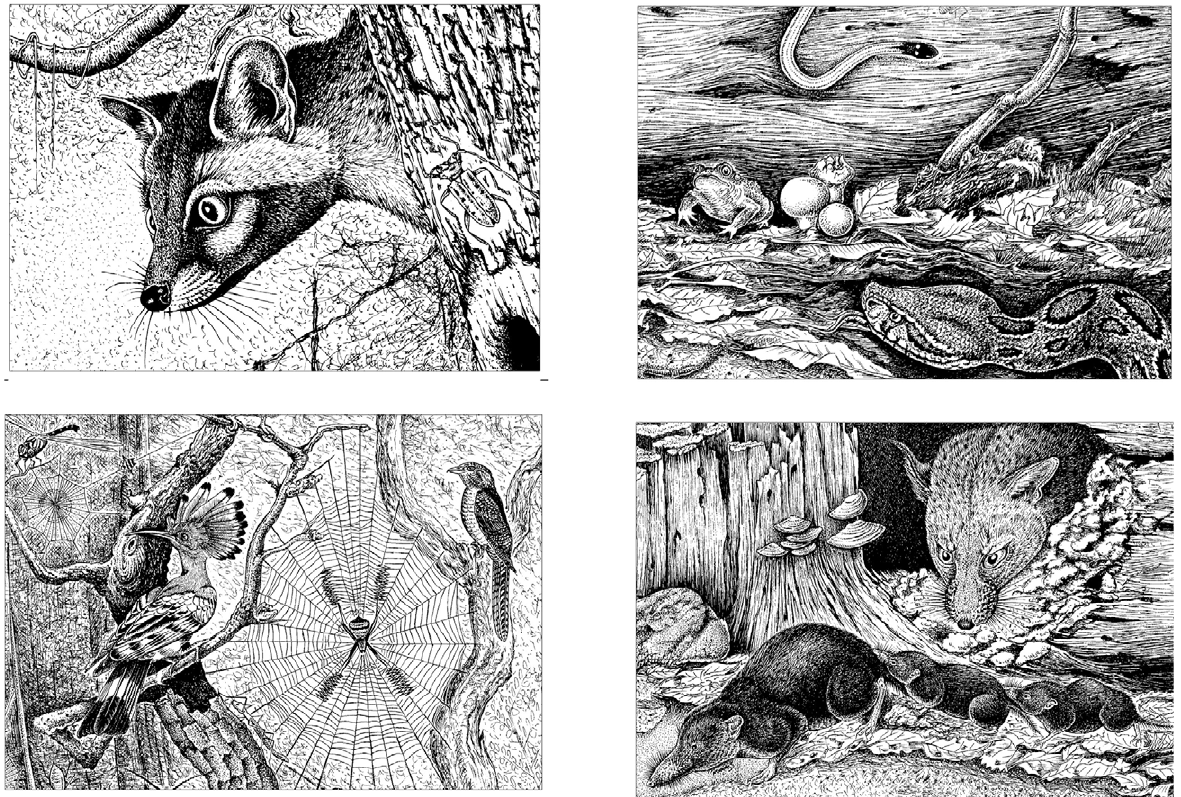
Image 15. Postcards depicting wildlife of the tropical dry evergreen forest. Illustrated using technical pen (Rotring .20 and